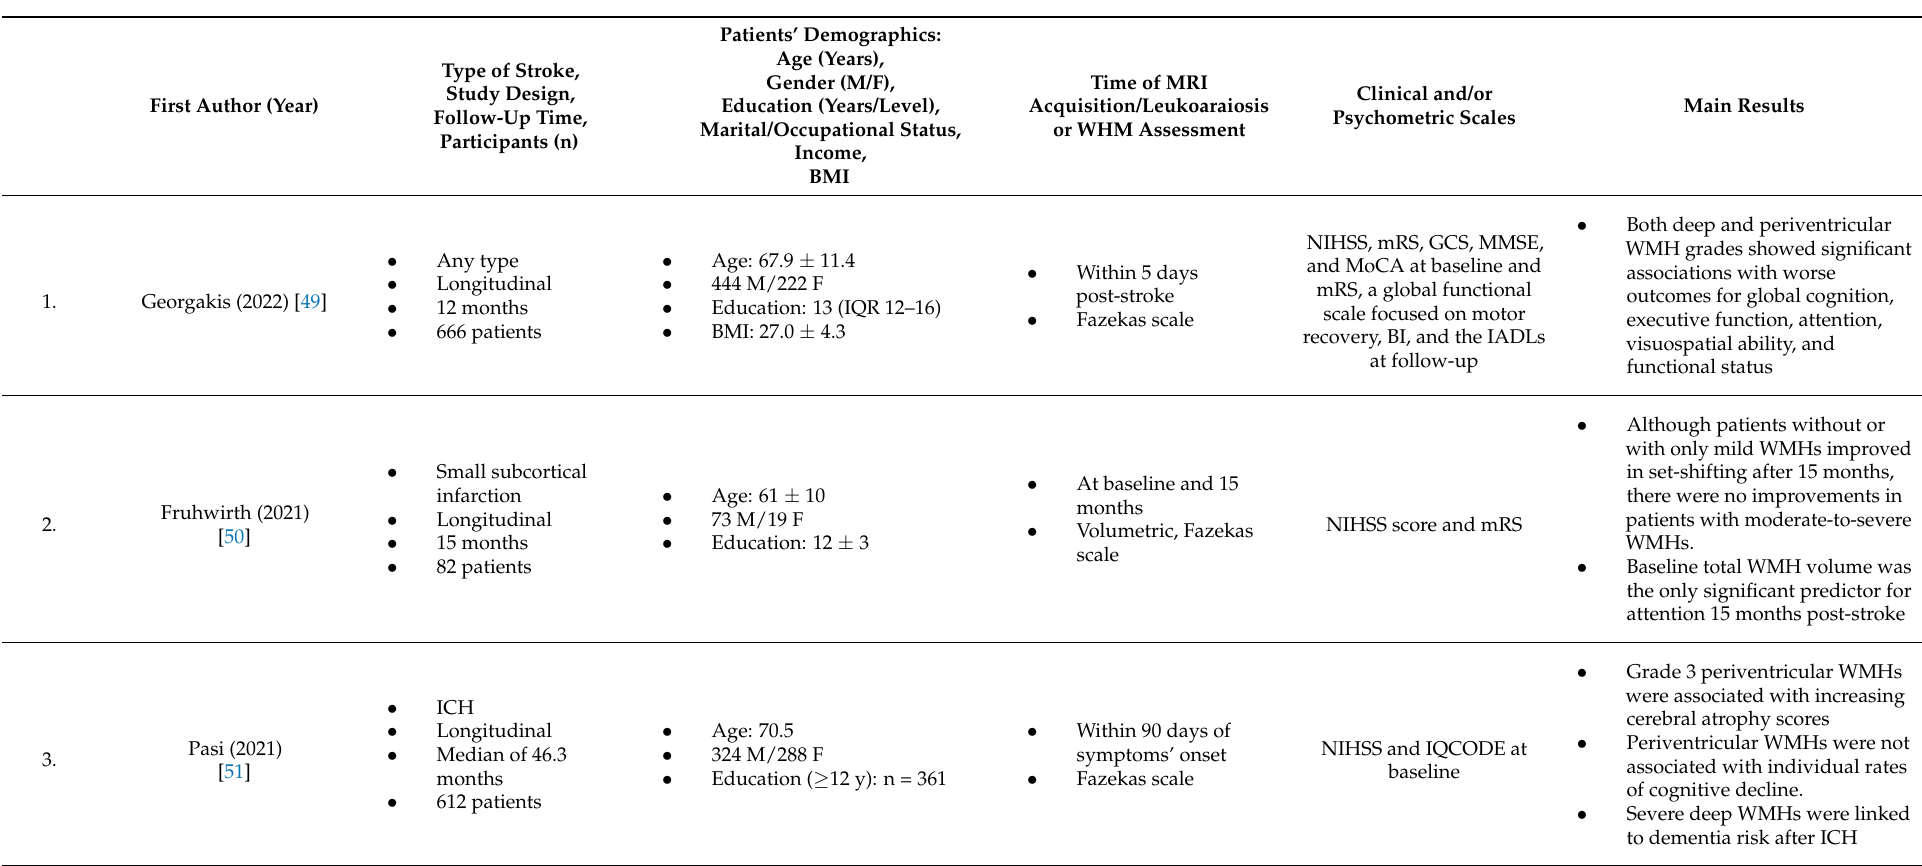
Table 3. Characteristics of included studies focusing on